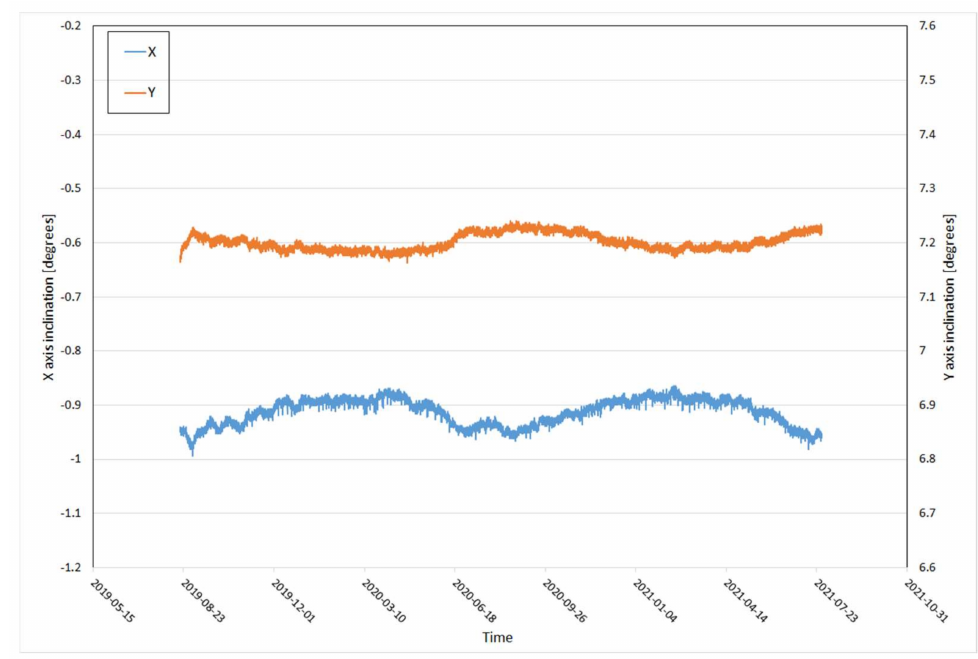
Figure 18. Changes in the inclination (X and Y components) registered at the first station with the sensor installed in the pillar side (1-O).